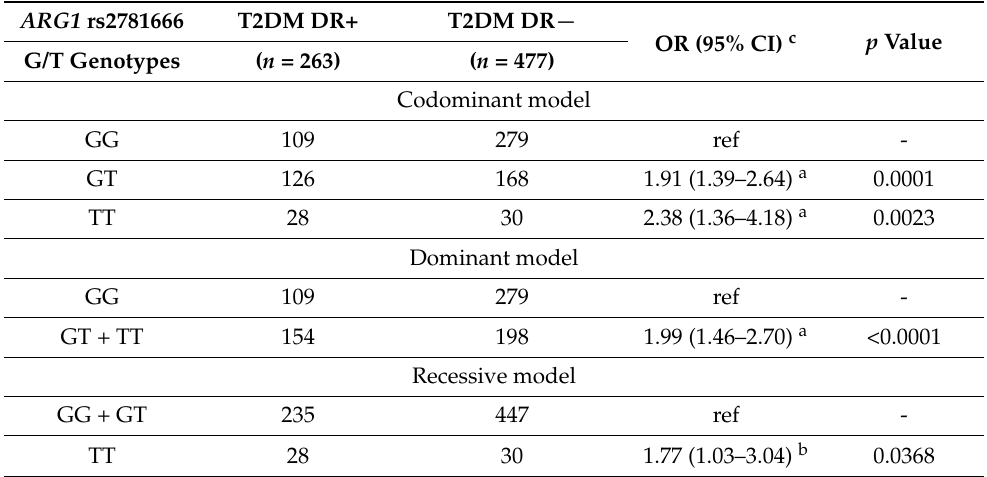
Table 3. Distribution of the ARG1 rs2781666 polymorphism according to the model of inheritance. ARG1 rs2781666